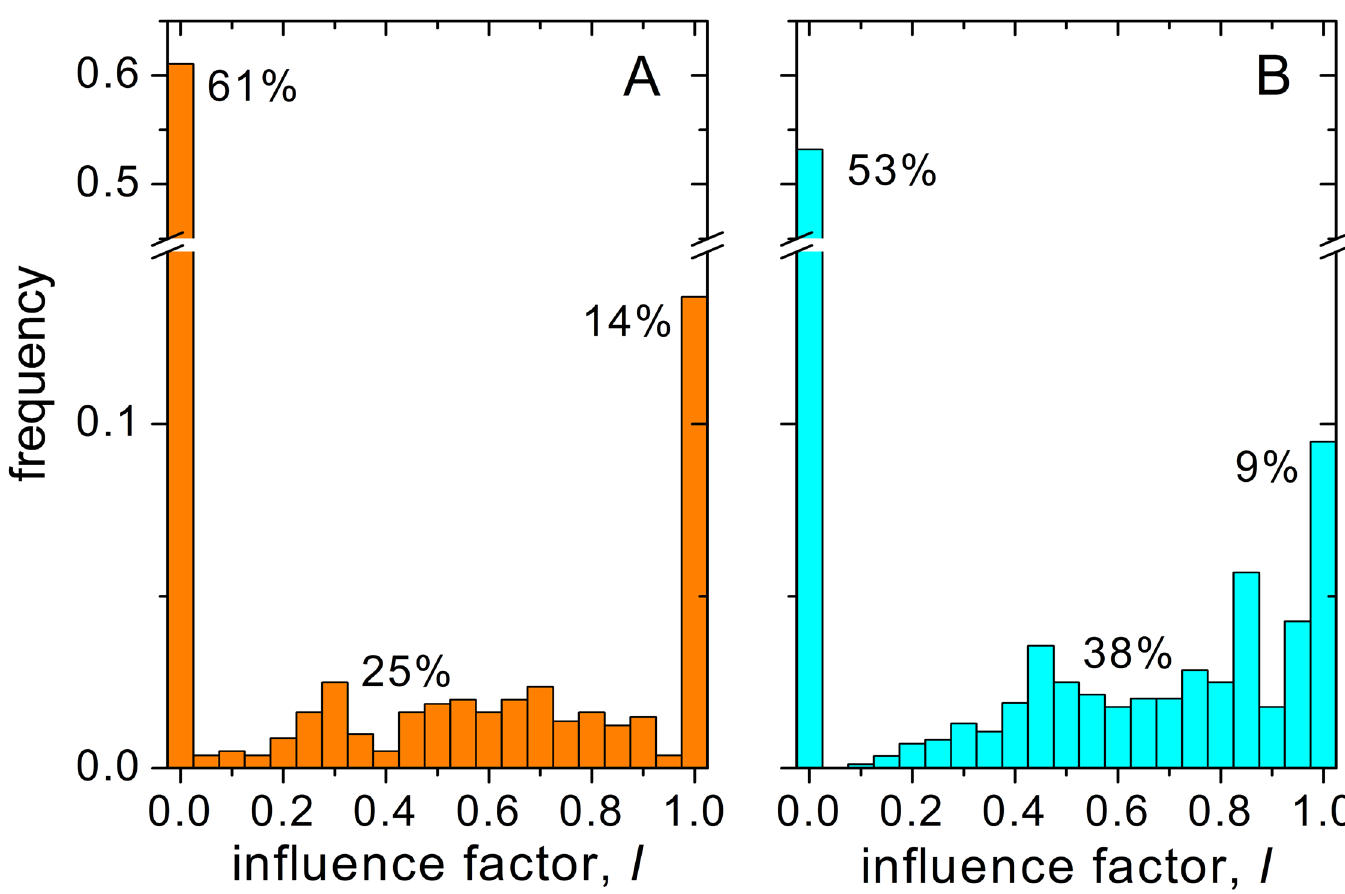
Fig 1. Distribution of the influence factor. The histograms show the frequency for the influence factor I recorded in the experiment. Percentages stand for the frequencies of answers (rounded to integer values) where the opinion is kept unchanged ( I = 0), where the reference opinion is adopted ( I = 1), and where a compromise is reached (0 < I < 1). The columns corresponding to I = 0 and I = 1 respectively incorporate the answers with I < 0 and I > 1. A: Individual influence (class A questions). B: Group influence (class B